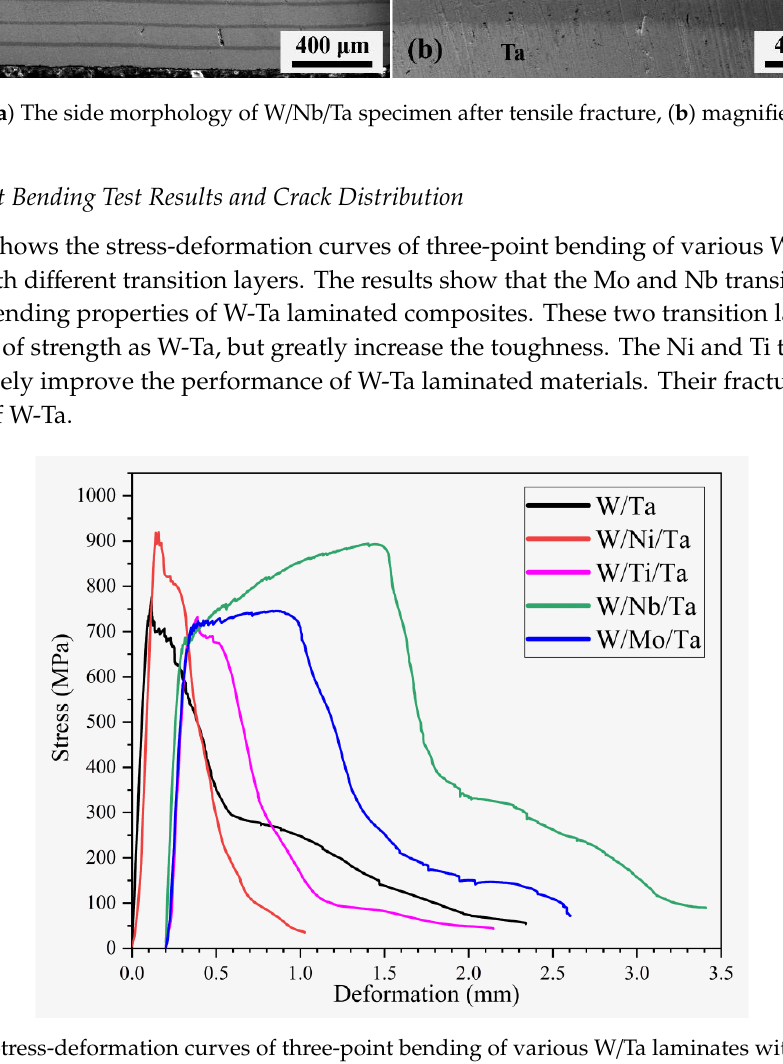
Figure 7. Stress-deformation curves of three-point bending of various W / Ta laminates with di ff erent transition layers.